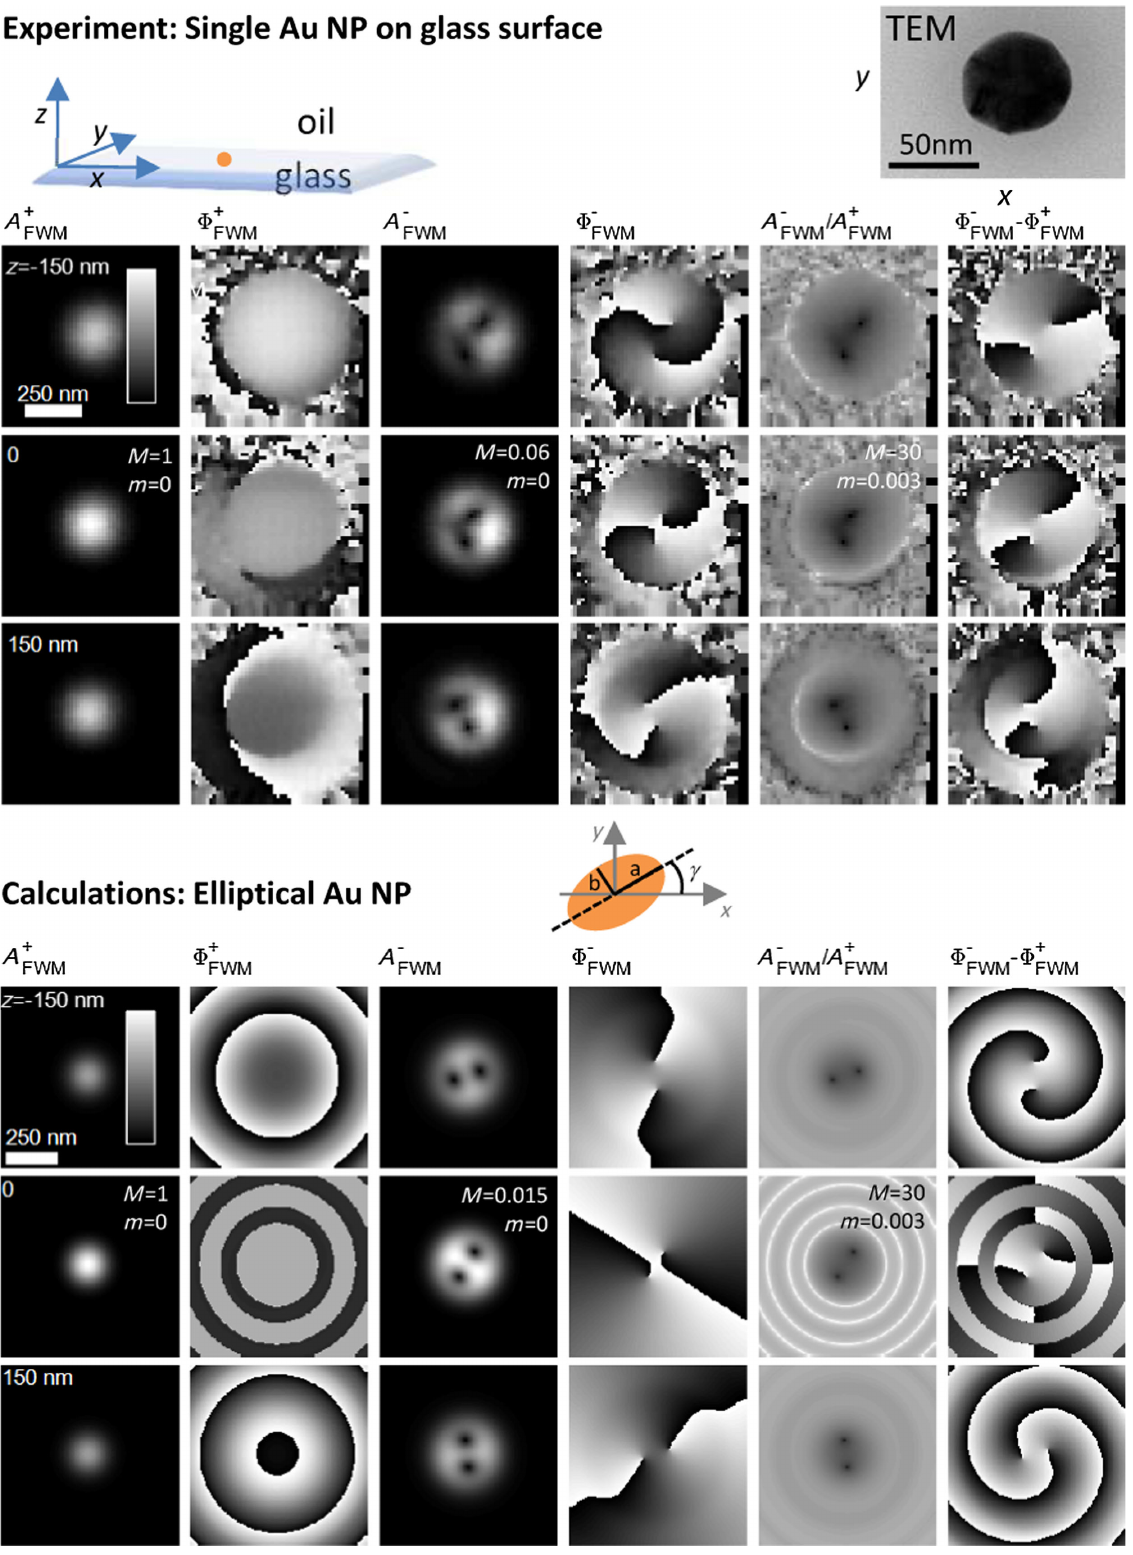
FIG. 4. FWM ofa single NP attached on glass. We show the amplitude and phase as a functionof NP positionin the ð x; y Þ plane at different axial positions z . Thelineargrey scale is from − π to π for phasesandfrom m to M for field amplitudes. Theamplituderatio isona logarithmic scaleover4ordersofmagnitude.Experiment:ThetopinsetshowsasketchofthesampleandaTEMimageofatypicalNPfromthebatchused. The pump (probe) power at the sample was 18 μ W ( 9 μ W), with a 3-ms-pixel dwell time and 0.5-ps pump-probe delay time; the pixel size in plane (axial) was 17 nm (75 nm). Calculations assume particle asphericity in planewith semi-axes a ¼ 30 . 135 nm and b ¼ 30 nm (see